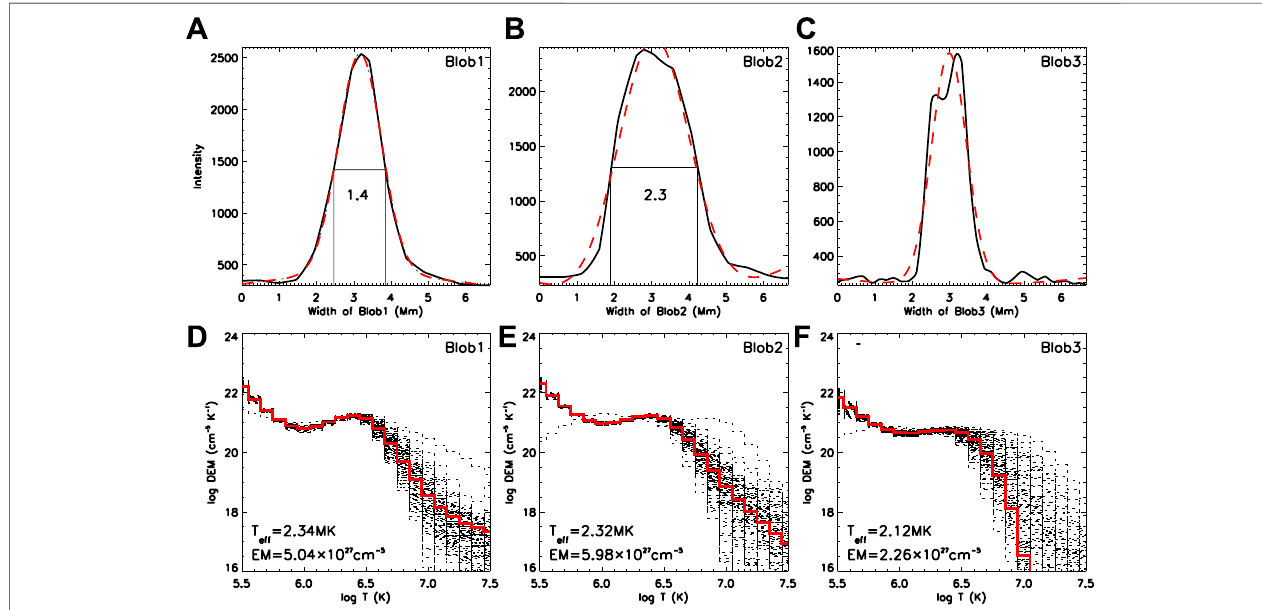
FIGURE10| Thewidth(upperpanels)andDEMdistribution(lowerpanels)ofBlobs1,2and3inPhase2.In (A) , (B) ,and (C) :theblacksolidcurvesaretheintensity variation of the Blobs 1, 2 and 3 perpendicular to the jet; the red dashed lines are Gaussian fi tting with the width values taken at the full width of half maximum (FWHM) aftersubtractingthebackgroundintensityvalues. (D) , (E) ,and (F) showtheDEMpro fi lesofthecoreregionsinBlobs1,2and3;theredsolidlinesstandforthebest- fi tted DEM curves from the observed values; the black lines represent the reconstructed curves from the 100 MC simulations.